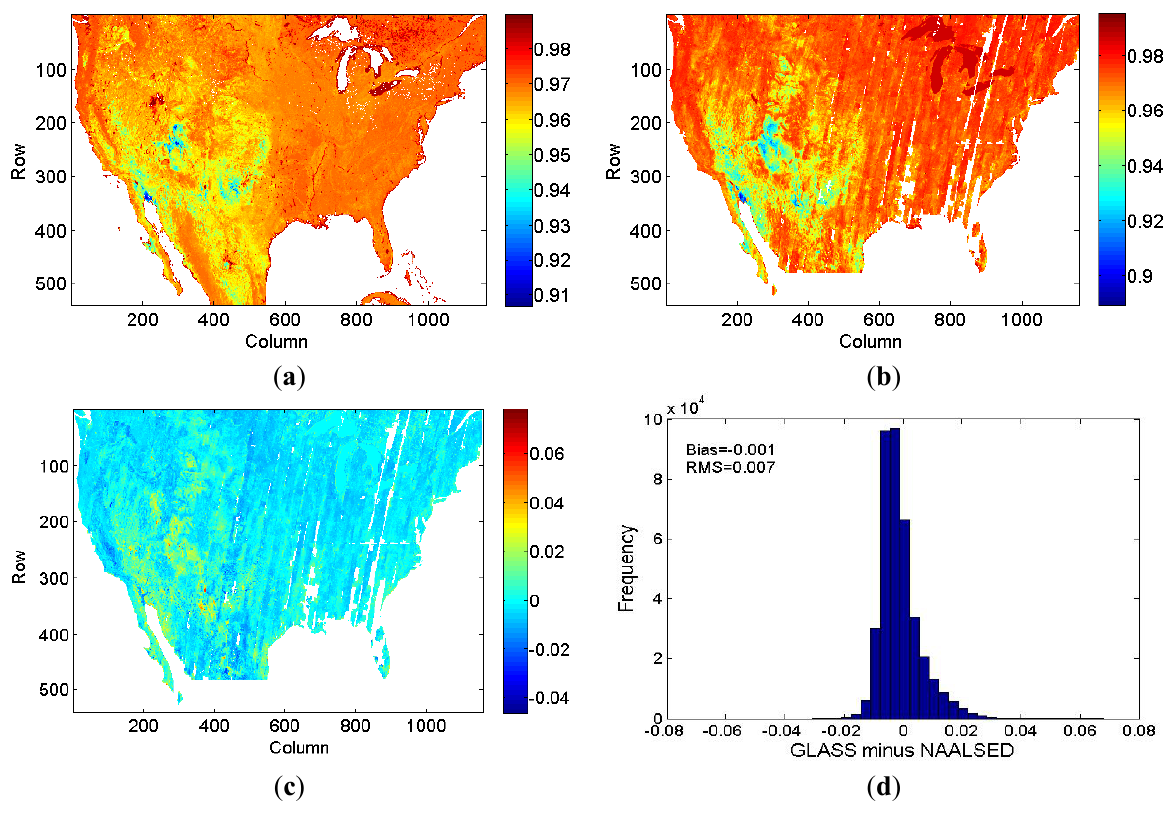
Figure 1. Comparison between NAALSED BBE and GLASS BBE for summer season. ( a ) GLASS BBE; ( b ) NAALSED BBE; ( c ) the difference between GLASS BBE and NAALSED BBE; ( d ) the histogram of the difference.